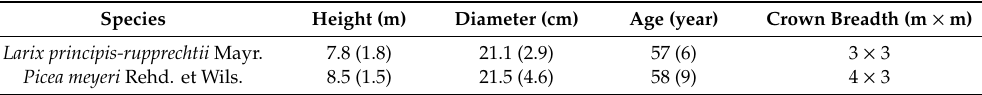
Table 1. Mean (standard deviation) of the characteristics of the sample trees. Species Height